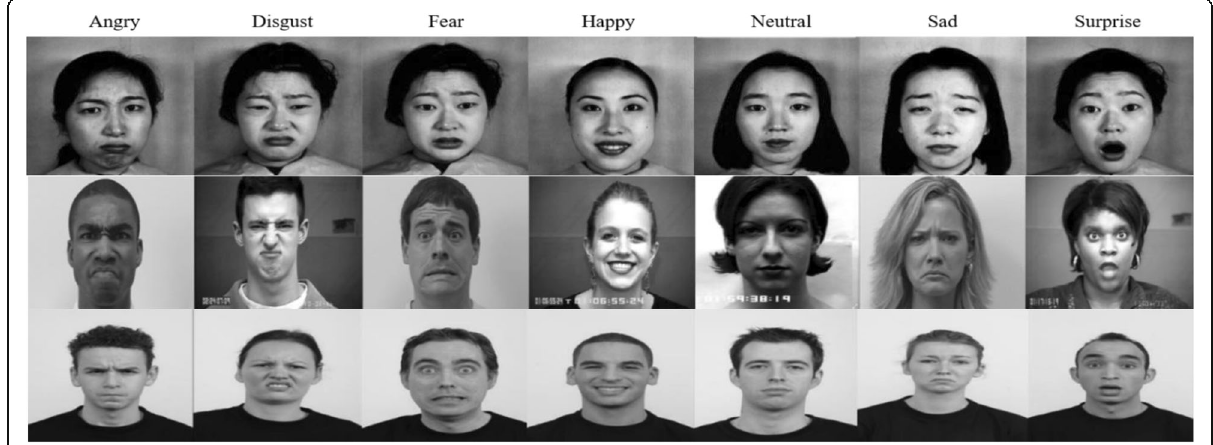
Fig. 3 Sample of seven expressions of each dataset starting from JAFFE (top), CK+ (middle), and RaFD